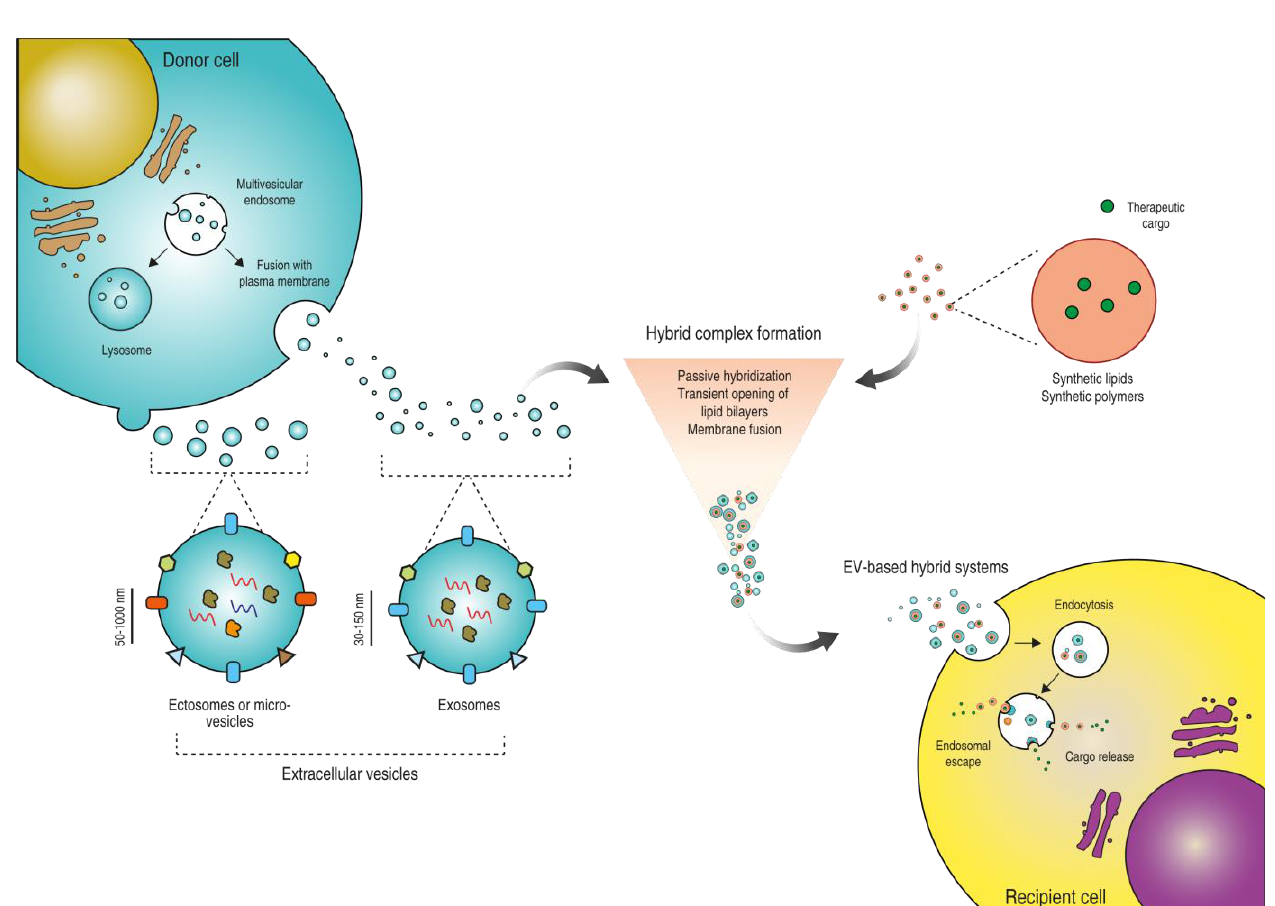
Figure 1. EV-based hybrid systems for drug delivery. Schematic representation of the biogenesis and release of EVs by the donor cell (light green). EVs produced upon the fusion of multivesicular endosomes with the plasma membrane or formed by budding of the cell membrane can be isolated and hybridized with synthetic nanoparticles (e.g., synthetic polymeric or lipidic nanoparticles loaded with a therapeutic cargo) through different production strategies in order to develop EV- based hybrid systems capable of delivering the cargo into recipient cells (yellow).